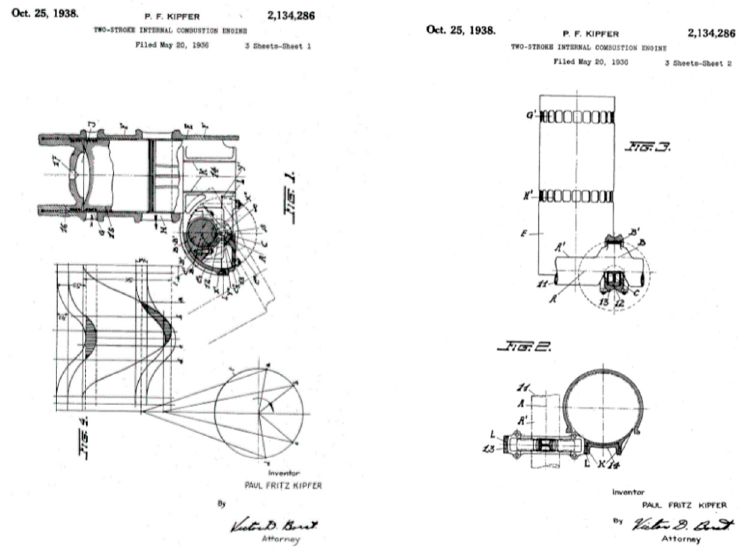
Figure 8. Kipfer 20 May 1936, two-stroke internal combustion engine US 2134286. Reproduced with